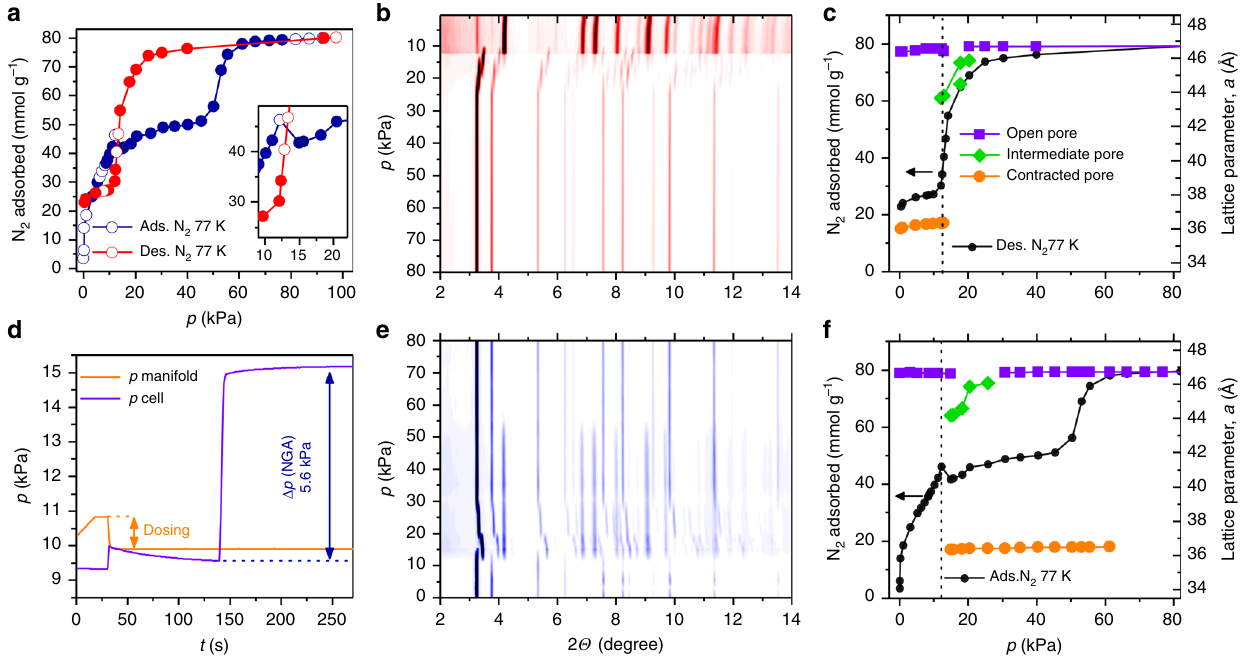
Fig. 2 In situ PXRD in parallel to nitrogen adsorption. a Adsorption isotherm of nitrogen at 77 K of DUT-49( 4 ) (adsorption points corresponding to collected PXRD patterns are represented as solid symbols) and d corresponding kinetic pro fi le of the NGA transition. b , e Contour plot of in situ PXRD patterns obtained during desorption (red, b ) and adsorption (blue, e ). c , f Lattice parameter evolution during desorption ( c ) and adsorption ( f ). op: open pore phase (cubic, Fm 3 m , a = 46.368(20) – 46.732(1) Å), cp: contracted pore phase (cubic, Pa 3, a = 36.020(1) – 36.504(16) Å), ip: intermediate pore phase